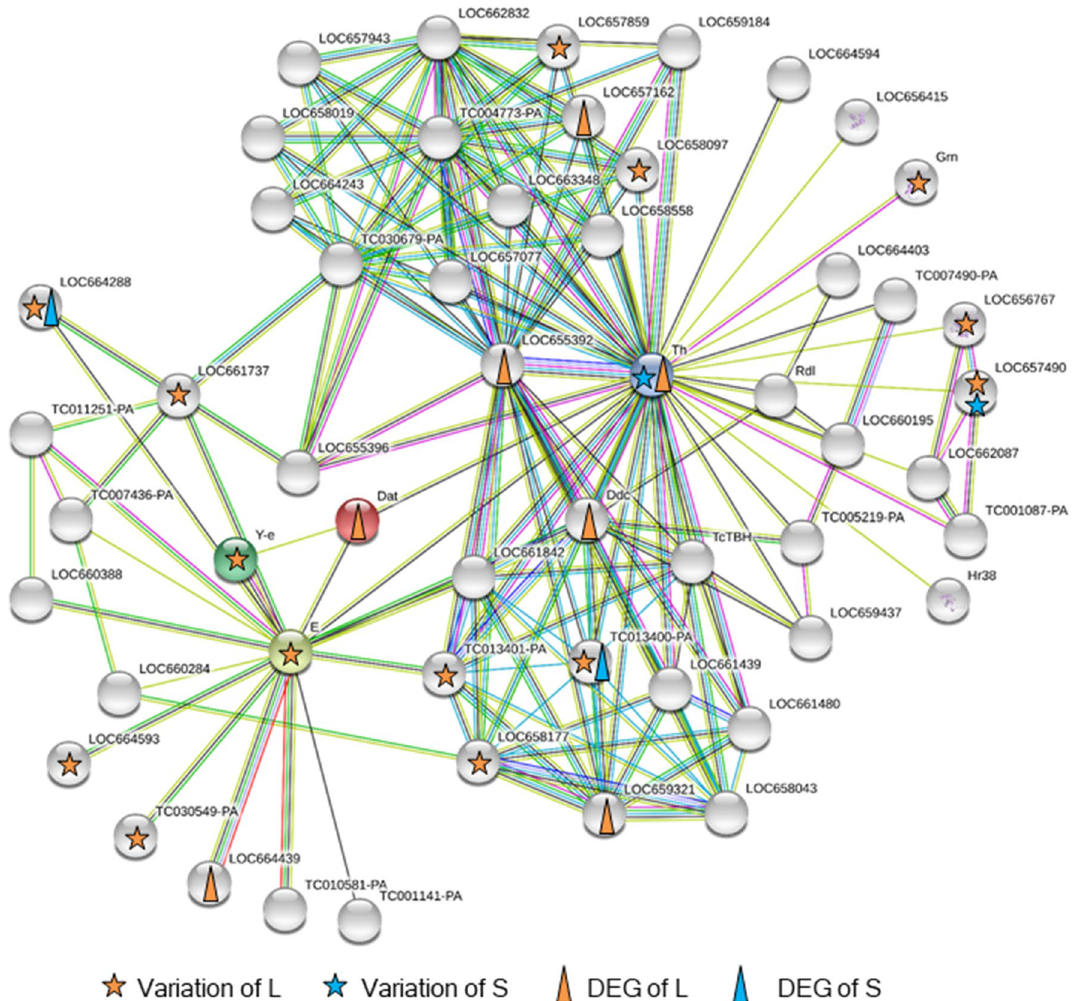
Figure 6. Protein–protein interaction (PPI) network including enzymes involved in dopamine metabolism. Lines indicate the relationships between genes. The network map is drawn using the STRING (version 11.0, https:// string- db. org/). Stars and triangles indicate genes with nonsynonymous variants and differentially expressed genes (DEGs),